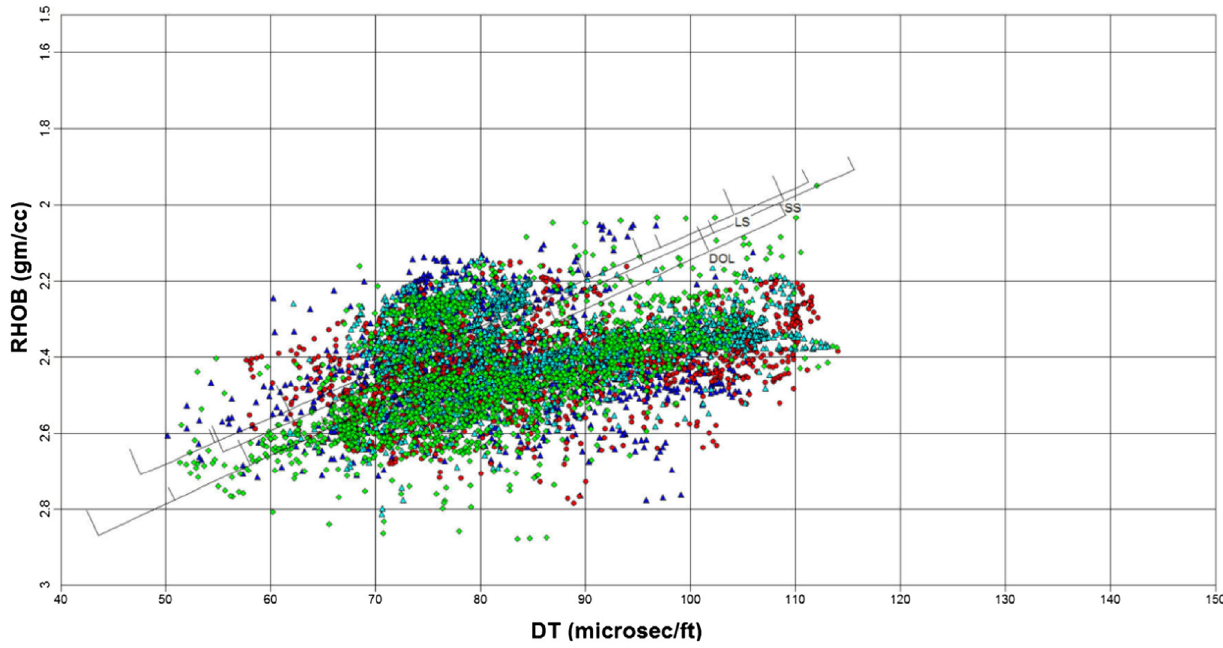
Fig. 9 Multi-well conditioned RHOB versus DT cross-plot to test consistency of